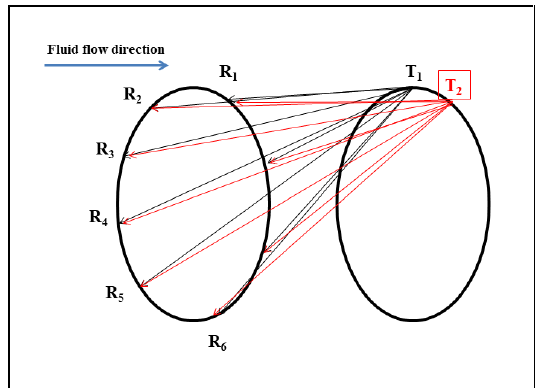
Fig. 2. Schema of the principle of transmission/ receiving of the